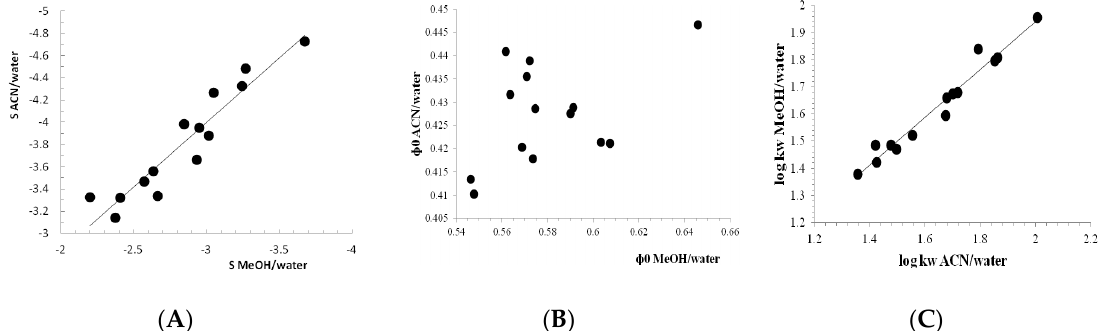
Figure 2. The cross relationship between the chromatographic lipophilicity parameters: S ( A ), φ 0 ( B ), and log k w ( C ), measured on chirobiotic column by the use of different eluent systems: ACN/water and MeOH/water.